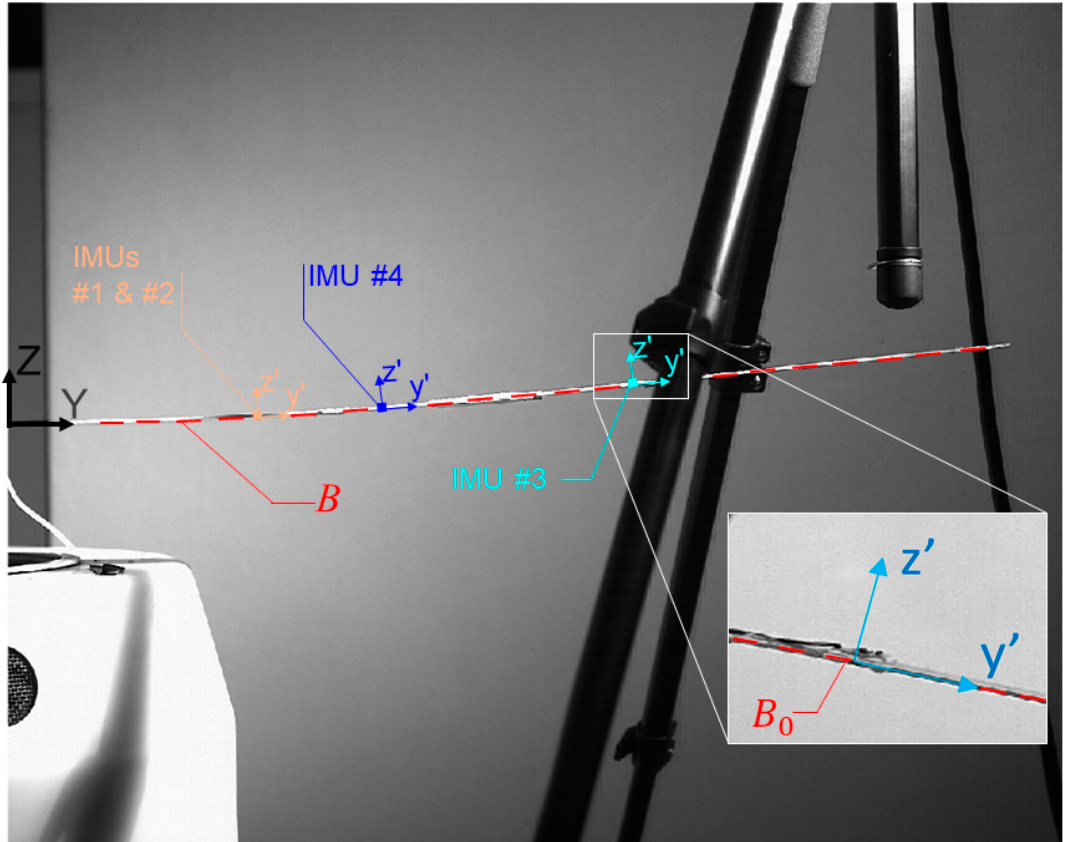
Figure 1. Global and local reference systems (RS). Note that the accelerometers’ own { O’,x’,y’,z’ } RSs (zoom box, bottom right corner) are not always corresponding to the global { O,X,Y,Z } RS but always consistent with the direction of the restoring force. Deformed ( B ( t ) ) and reference ( B 0 ) configurations, the latter one deflected under its own and sensors’ weights, are highlighted.